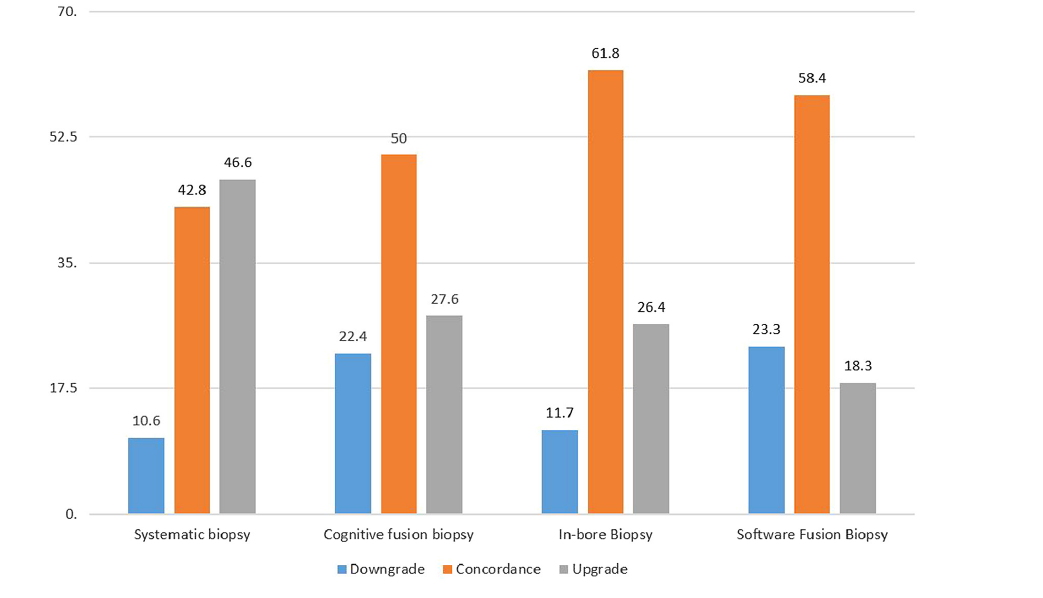
Figure 1. The downgrade, concordance, and upgrade rates of each biopsy technique.